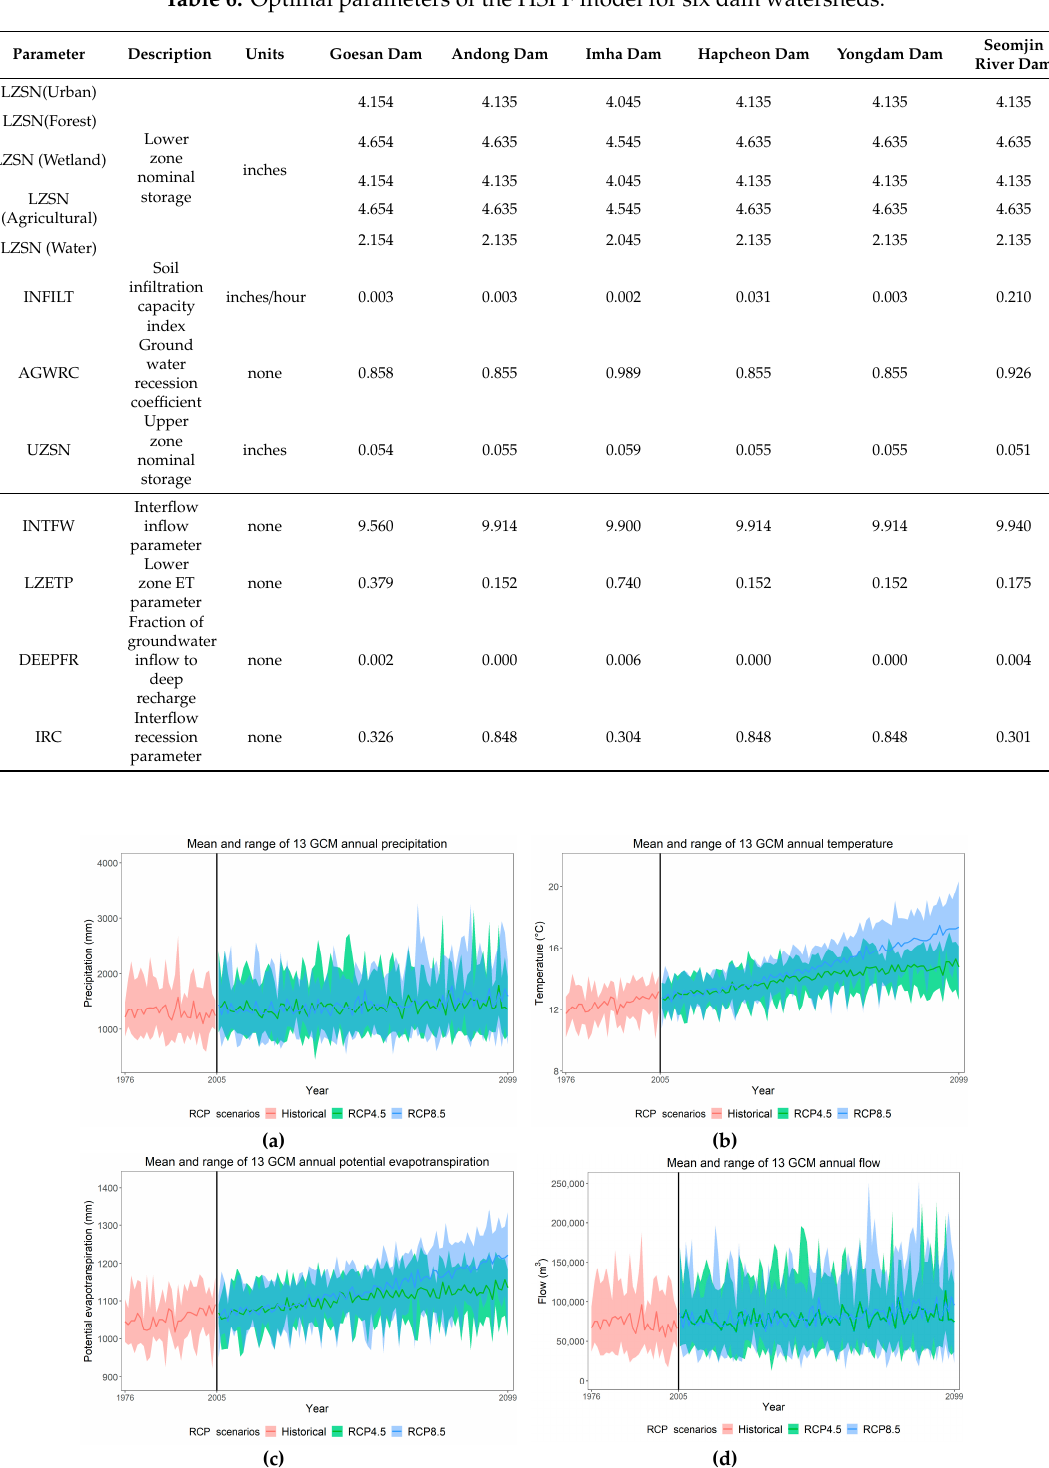
Table 6. Optimal parameters of the HSPF model for six dam watersheds.